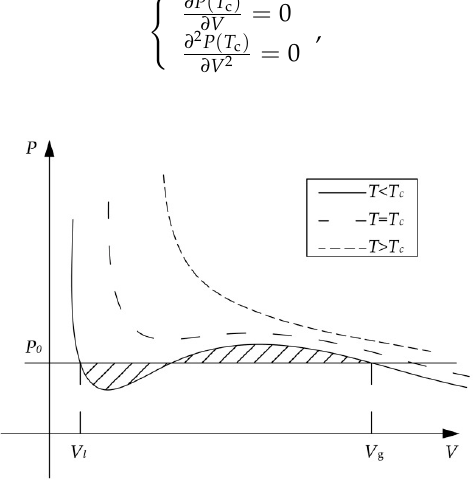
Figure 2. The equation of state of non-ideal fluid.